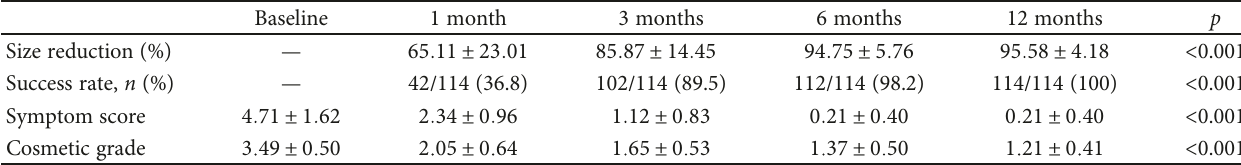
Table 2: E ffi cacy of PPI in cystic thyroid nodules at follow-up.